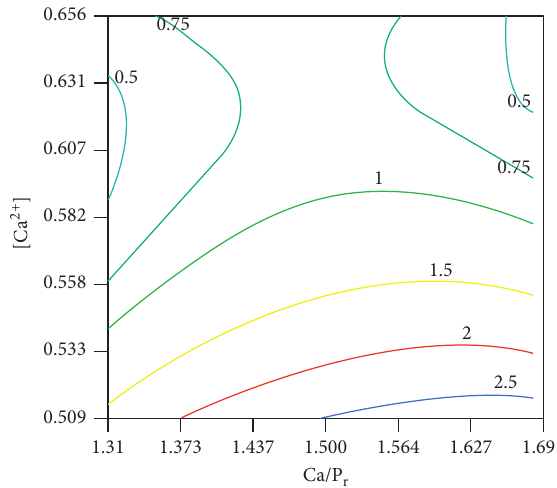
Figure 3: Isoresponse contour plot for %O 2 −